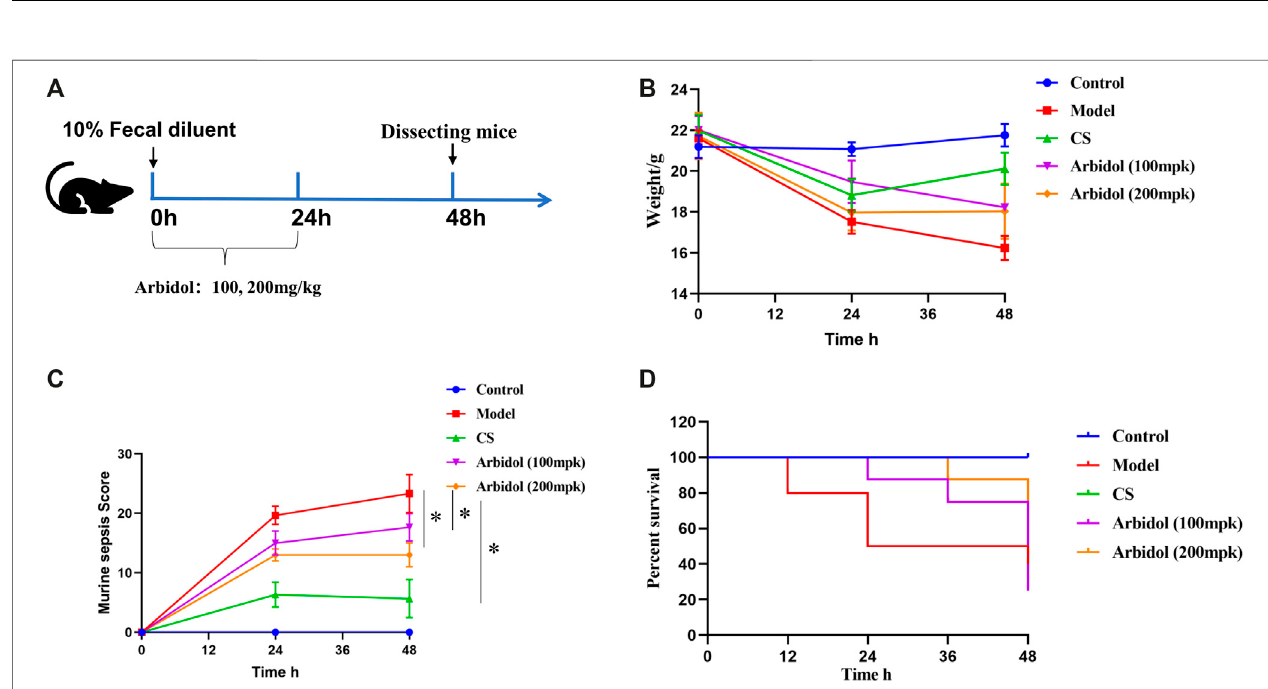
FIGURE3| Effectofarbidolonfecaldilution-inducedsepsisinmice (A) Experimentalschemeofmicesepsisinducedbyfecaldiluent (B) Changesinbodyweightin differentgroupsofmice(Control,Model,cefpiromesulfateorCS,100and200 mpkarbidol) (C) Theeffectofarbidolonmurinesepsisscore(MSS)ofthedifferentgroups of mice described above (D) The effect of arbidol on the survival time of the different groups of mice described above. Values are presented as the mean ± SEM (n (cid:1) 5), # p < 0.05, signi fi cantly different from control group; * p < 0.05, signi fi cantly different from model groups.